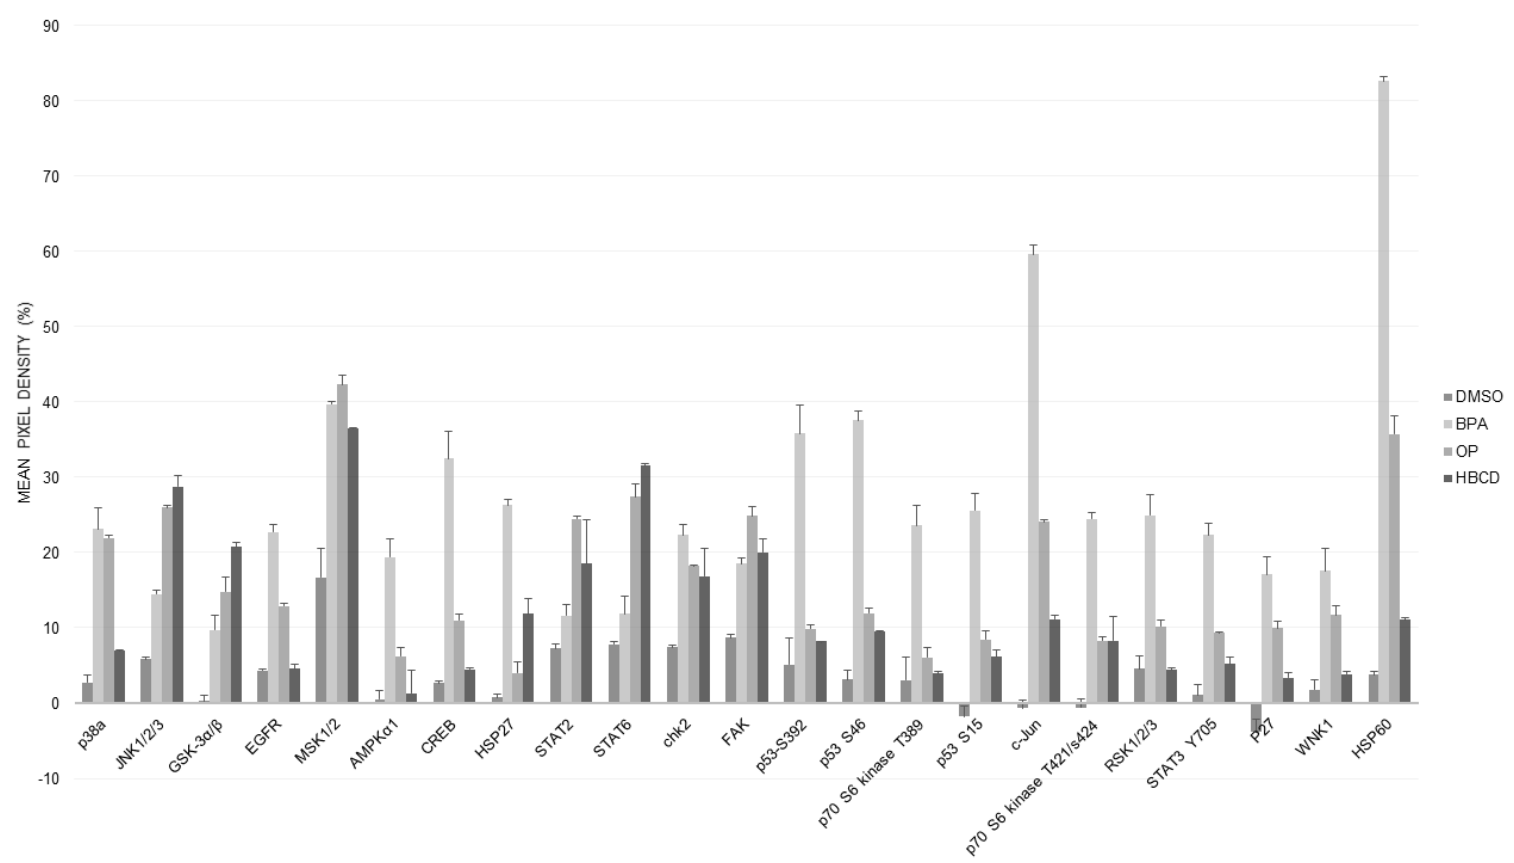
Figure 4. Phospho kinase array analysis after exposure of HME1 to low nanomolar concentrations of three agents (BPA, OP, and HBCD) for two months as compared to the vehicle (DMSO). Whole cell extracts were processed with “human phospho-kinase array” ready-made kit. The array analysis 43 kinase phosphorylation sites and 2 related total proteins with carefully selected specific capture antibodies. (Proteome Profiler; R&D Systems, Minneapolis, MN, USA). Data were analyzed using “image J” program and the Mean ± SEM was blotted as percentage (in relation to the positive control spot). Out of the 43 tested proteins, only the proteins which showed a change ratio of at least two times higher than that observed in the vehicle treatment (DMSO) are shown. n = 4 (2 biological × 2 technical).